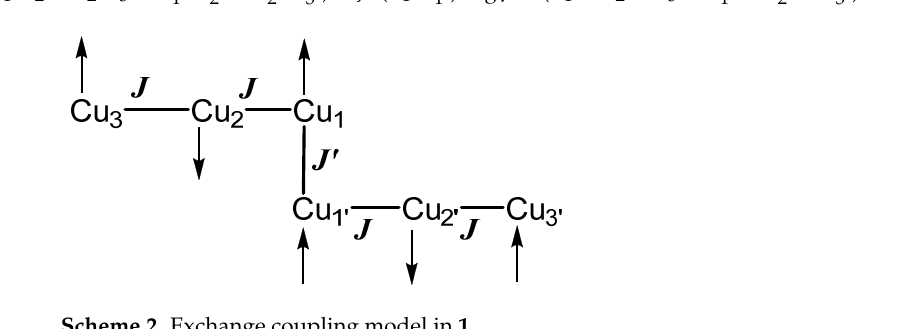
Figure 5. χ M T versus T curve for 1 (H = 0.5 kOe). Inset: M versus H curves measured at 2.5 and 5 K. The solid lines represent the best-fit curves (see